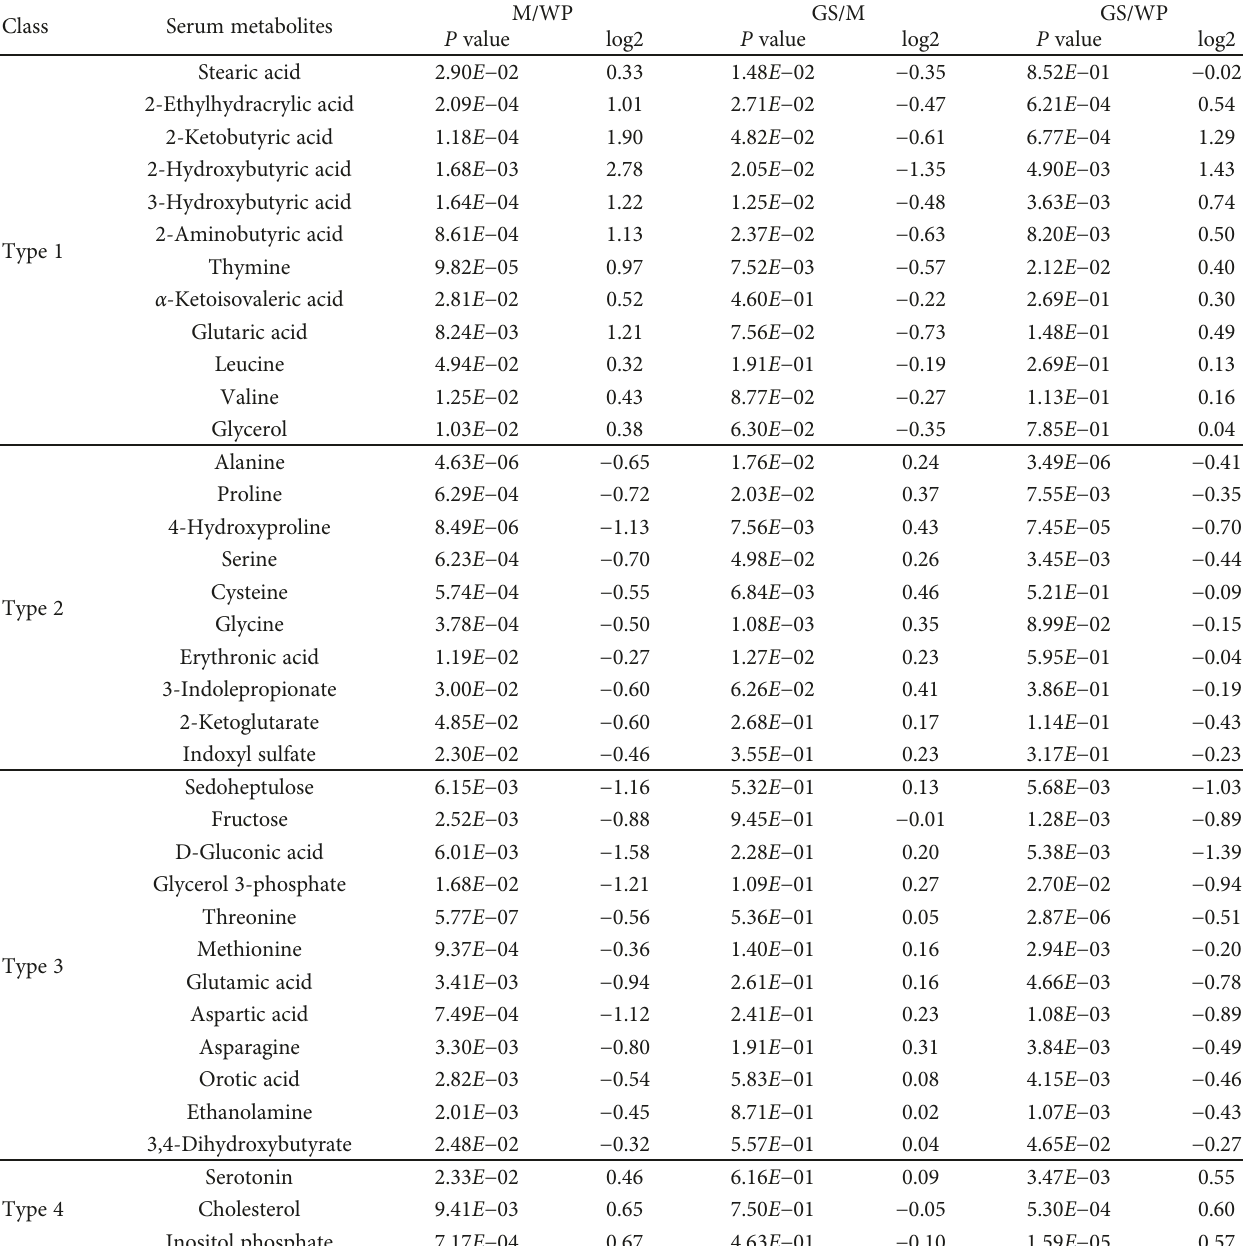
Table 3: Di ff erential expressed serum